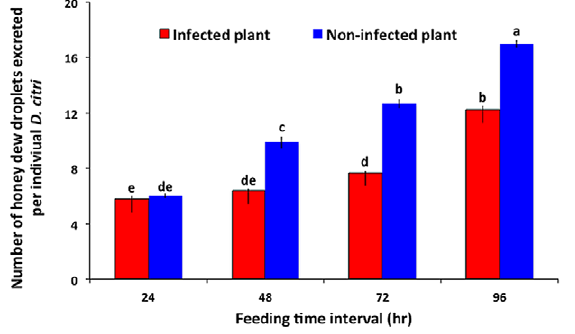
Figure 4. Feeding efficiency of D.citri on Las-infected versus non-infected citrus leaves as measured by honeydew excre- tion. Bars labeled with different letters are significantly different from one another (Tukey’s HSD test, p , 0.05). doi:10.1371/journal.ppat.1002610.g004 PLoS Pathogens |